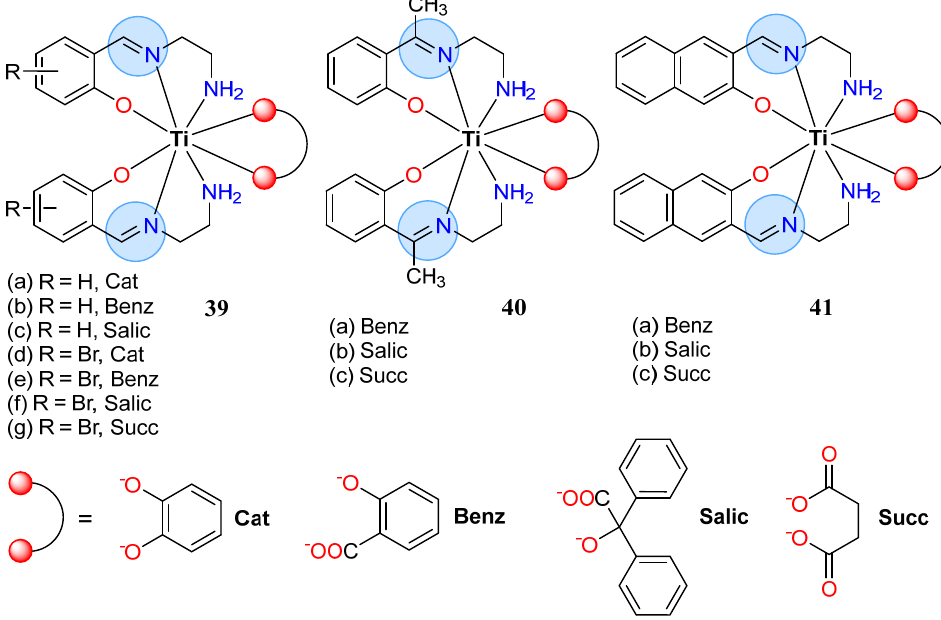
Figure 18. Ti(IV) complexes with non-symmetrical Schiff base ligands derived from ethylenediamine with antimicrobial properties.